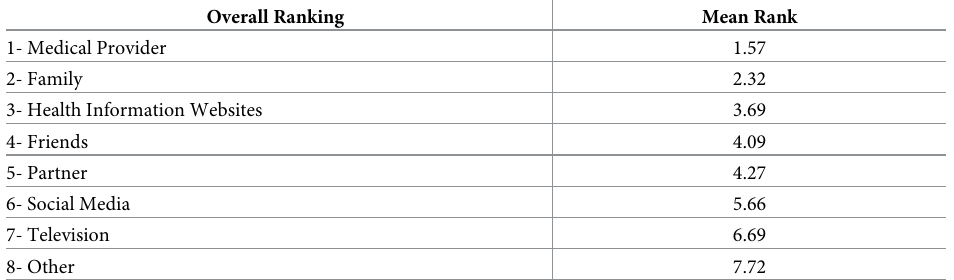
Table 2. Mean ranking by survey respondents for sources they prioritize when making health decisions (1 = top priority, 8 = lowest priority).